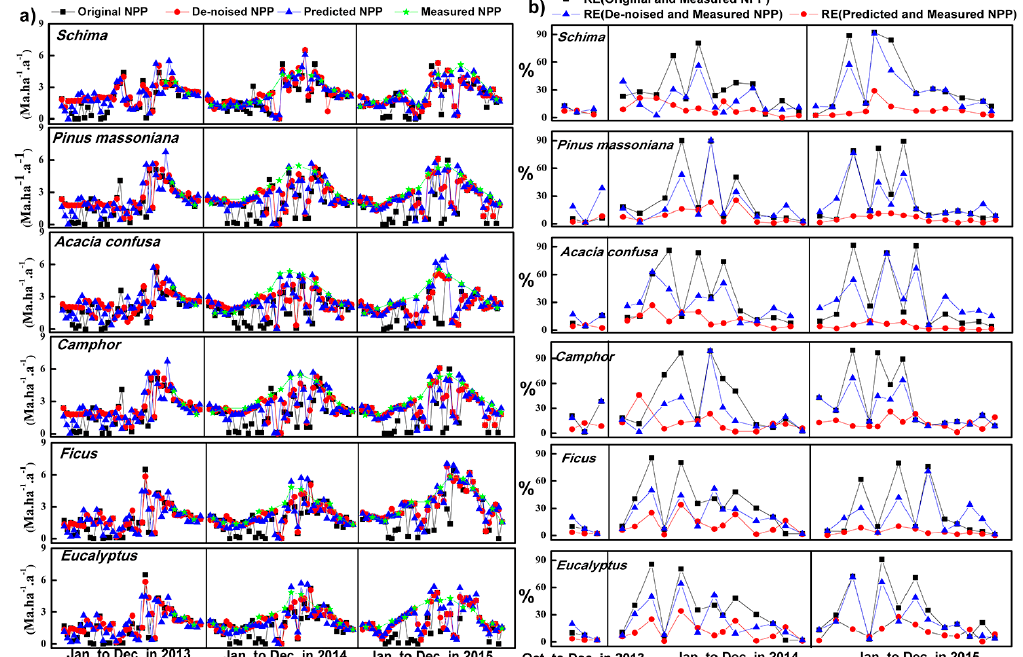
Figure 5. ( a ) Time series of the original MODIS-NPP data from MOD17, de-noised MODIS-NPP data, predicted MODIS-NPP data, and the measured NPP data from 2013 to 2015; ( b ) RE between the original MODIS-NPP data and the measured NPP data, RE between the de-noised MODIS-NPP data and the measured NPP data, and RE between the predicted MODIS-NPP data and measured NPP data based on the six representative sample plots.